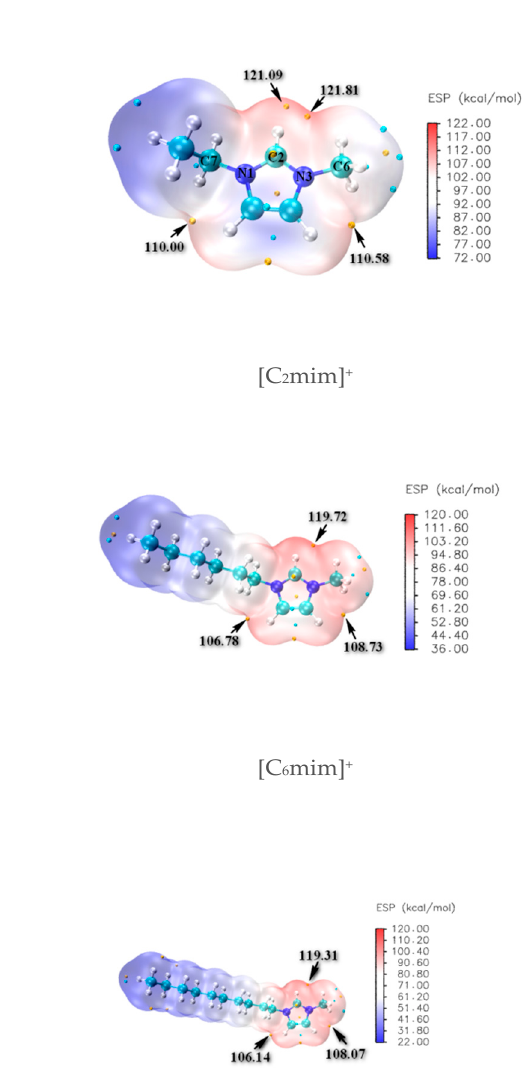
Figure 1. Molecular electrostatic potential (MEP) maps of the thymine (T) and imidazolium cations -[C n mim] + ( n = 2, 4, 6, 8, 10).